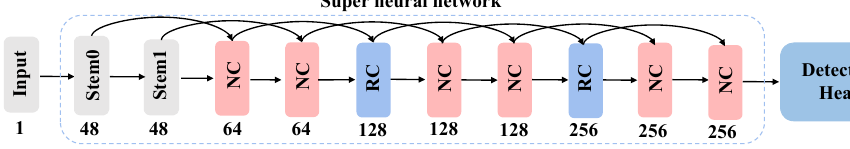
Figure 4. The super network for architecture search.